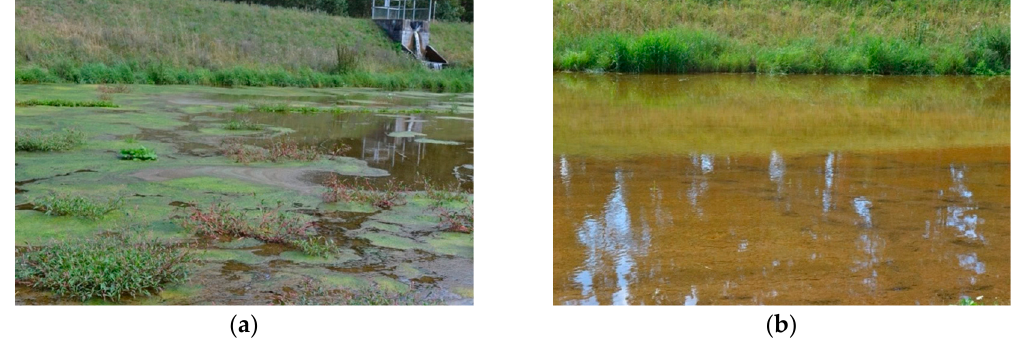
Figure 2. Turbidity measurements at different stages along the two treatment processes (FAU). The middle bar is the mean value and the top and lower bars show the standard deviation. The dotted line is the contact filter treatment process and the solid line is the control treatment process.